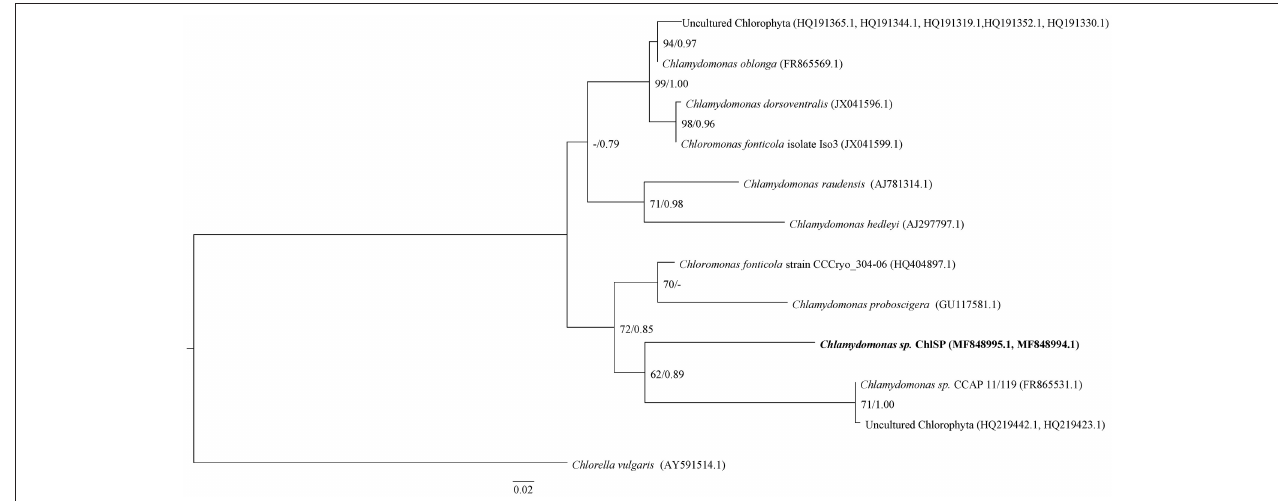
FIGURE 2 | ML tree inferred based on the rDNA ITS and 5.8S sequences. Numeric values at nodes are the ML BP (bootstrap percentage)/BI PP (posterior probability). Dashes (-) indicate < 50% percentage values. –Ln likelihood was 1423.138; the substitution model chosen was GTR + G; nucleotide frequencies A = 0.2388, C = 0.2759, G = 0.2330, T = 0.25211; substitution model rate matrix (R(a)[A-C] = 2.2194, R(b)[A-G] = 3.4983, R(c)[A-T] = 2.2692, R(d)[C-G] = 1.1608, R(f)[C-T] = 8.7438); gamma shape parameter = 0.310. Scale bar = 0.02 substitutions per site. Boldface indicates the new species, the ChlSP strain, described in this